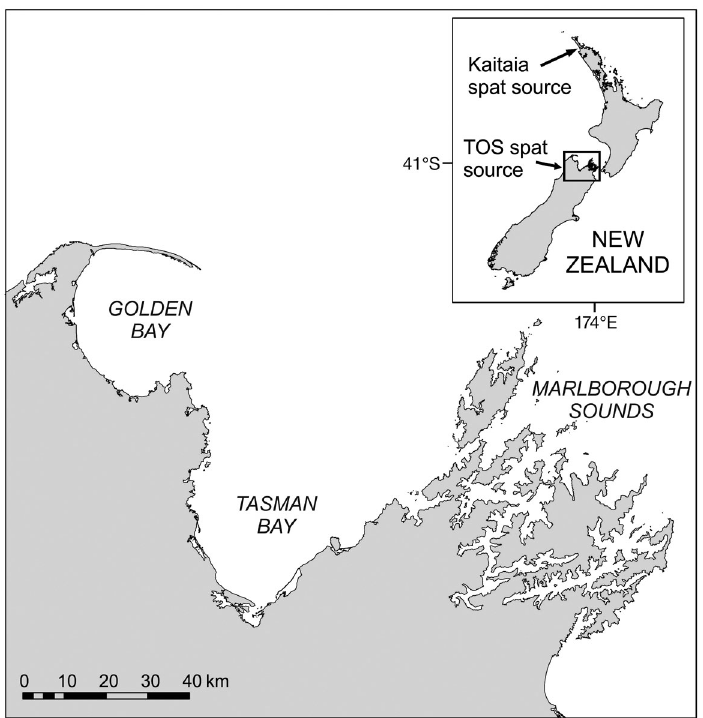
Fig. 1. Map showing Marlborough Sounds region of central New Zealand, and mussel spat supply locations referred to in the text. TOS: